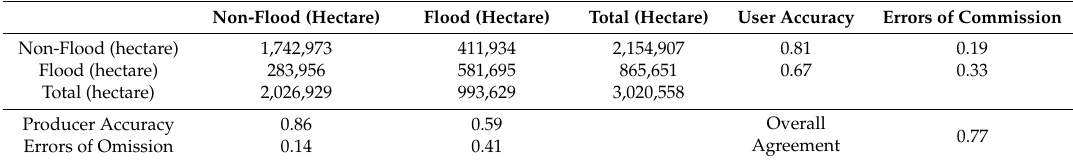
Table 3. The spatial agreement between SMAP and FEMA-SDMI derived inundation acreage of Baton Rough Flood.